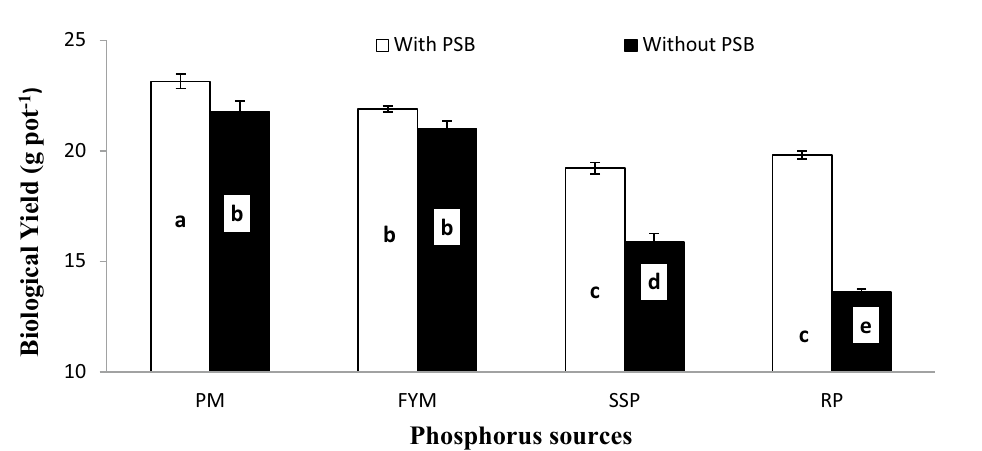
Figure 8. Interactive effect of P sources and PSB on wheat biological yield (g pot −1 ). Graph bars having different letters are significantly different at α = 0.05. Errors bar represent standard error for the mean of three